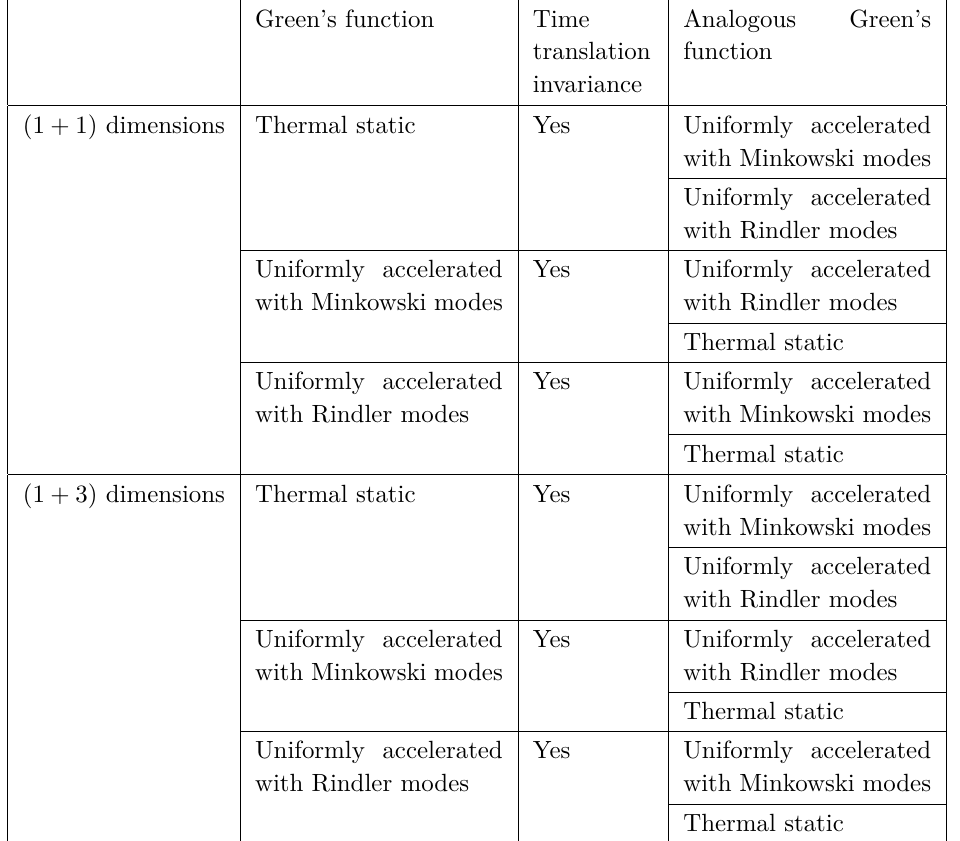
Table 3 . Characteristics of different Green’s functions (observers with uniform acceleration or static in thermal